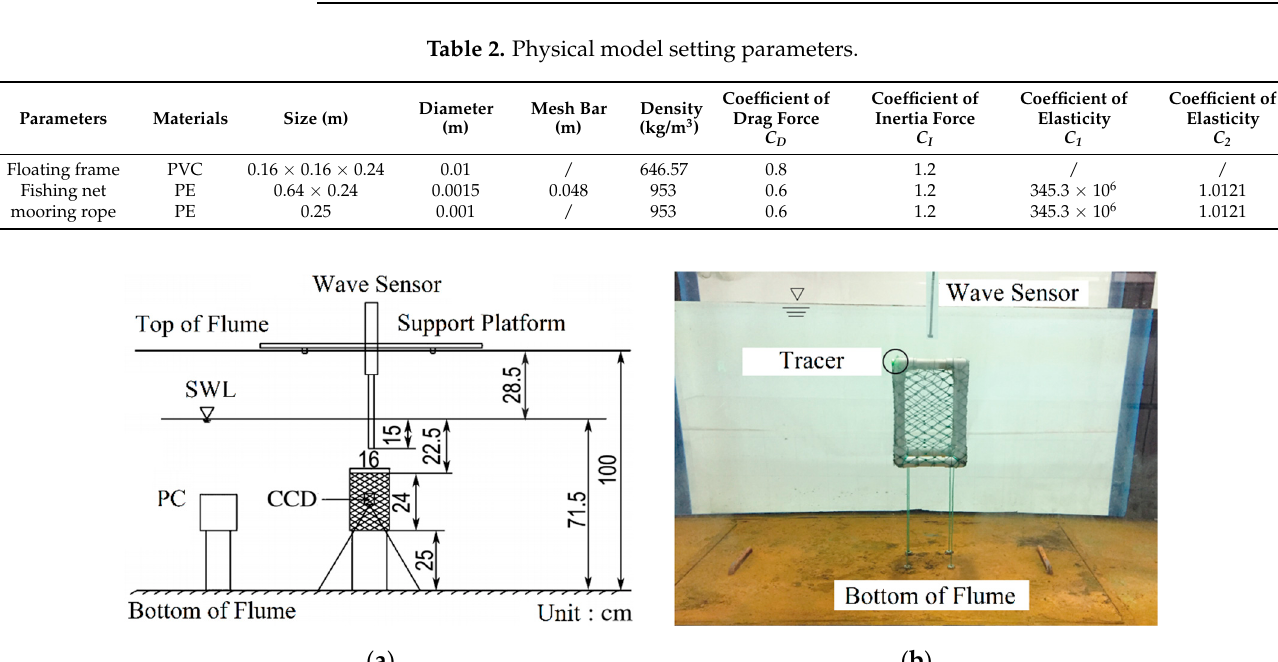
Figure 4. Experiment layout of a floating fish reef in a flume. ( a ) Arrangement of experiment instruments. ( b ) Physical model of floating reef.